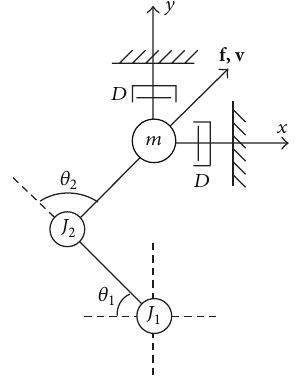
Figure 3: Virtual mass and viscosity.